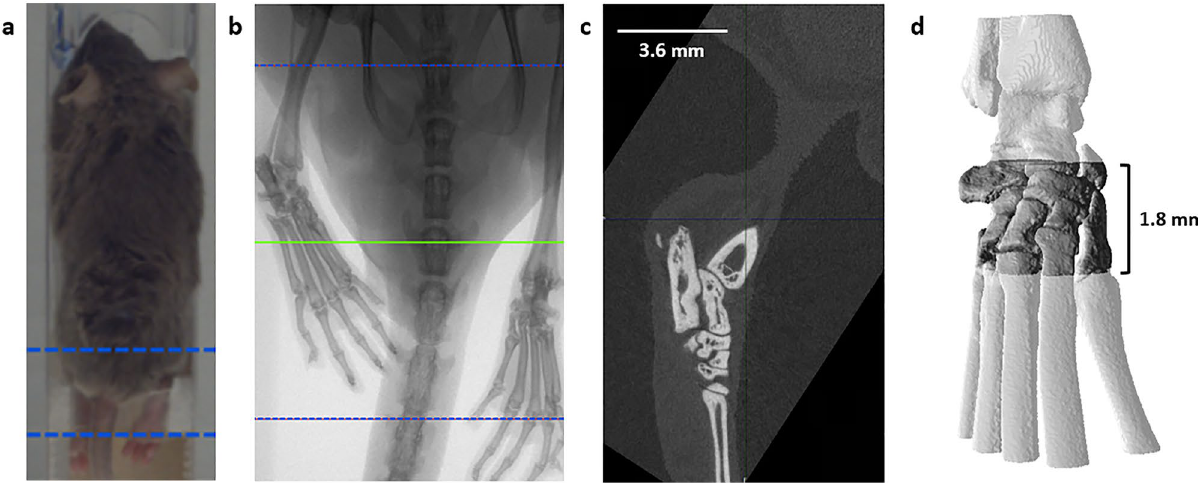
Figure 1. ( a ) In vivo imaging affords longitudinal assessment of the hind paws in the murine CIA model. ( b ) The acquired image is reconstructed using MI Labs software (https:// www. milabs. com/u- ct/; Version: 12.0). ( c ) Following reconstruction, the image is reoriented using VivoQuant software (http:// www. vivoq uant. com/, Version: VivoQuant™ 2020) such that the metatarsals are vertically aligned and orthogonal to the cross-sectional plane in the z-direction. ( d ) The ROI, traversing 1.8 mm vertically, is selected in VivoQuant software by noting anatomical tarsal